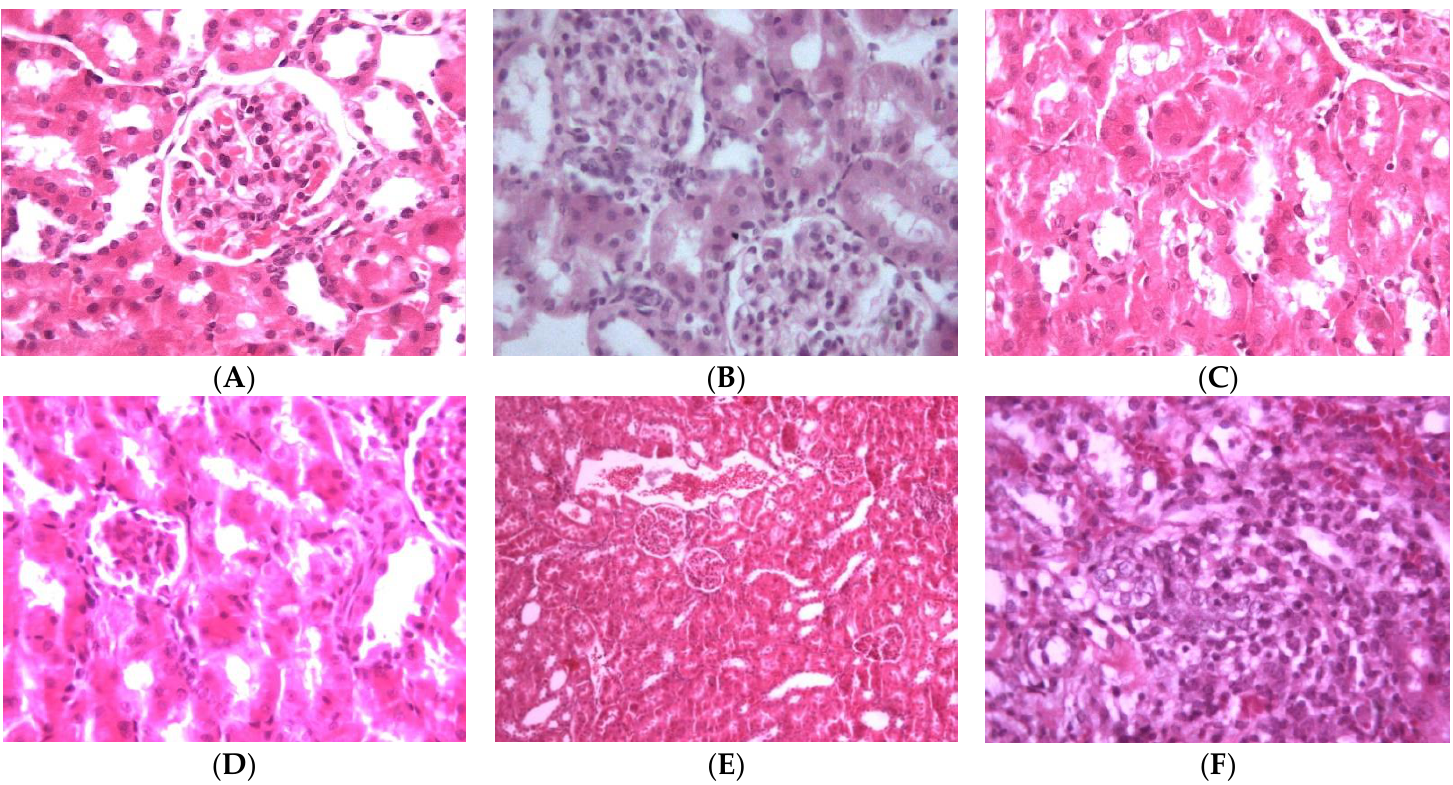
Figure 7. Light microscope pictures of kidney cells: ( A ) Normal cells. ( B ) Kidney cells of Pa-treated group showing abnormal cellular structures with degenerated corpuscle, reduced size of glomeruli, shrinkage of Bowman capsule, cloudy swelling in tubules and inflammatory infiltrate. ( C ) Kidney cells of rats treated with Pa and Sil showing no marked changes, nearly normal glomeruli and mild cloudy swelling in tubules. ( D ) Kidney cells of group treated with 3 showing moderate cortical atrophy and reduced size of glomeruli. ( E ) Kidney cells of group treated with 4 showing kidney cortical congestion, abnormal glomeruli (reduced in size) and cloudy swelling in tubules. ( F ) Kidney cells of group treated with 6 showing inflammatory cell infiltration at corticomedullary junction, kidney cortical infiltration, almost complete absence of Bowman space, degenerated and convoluted necrotic tubules.